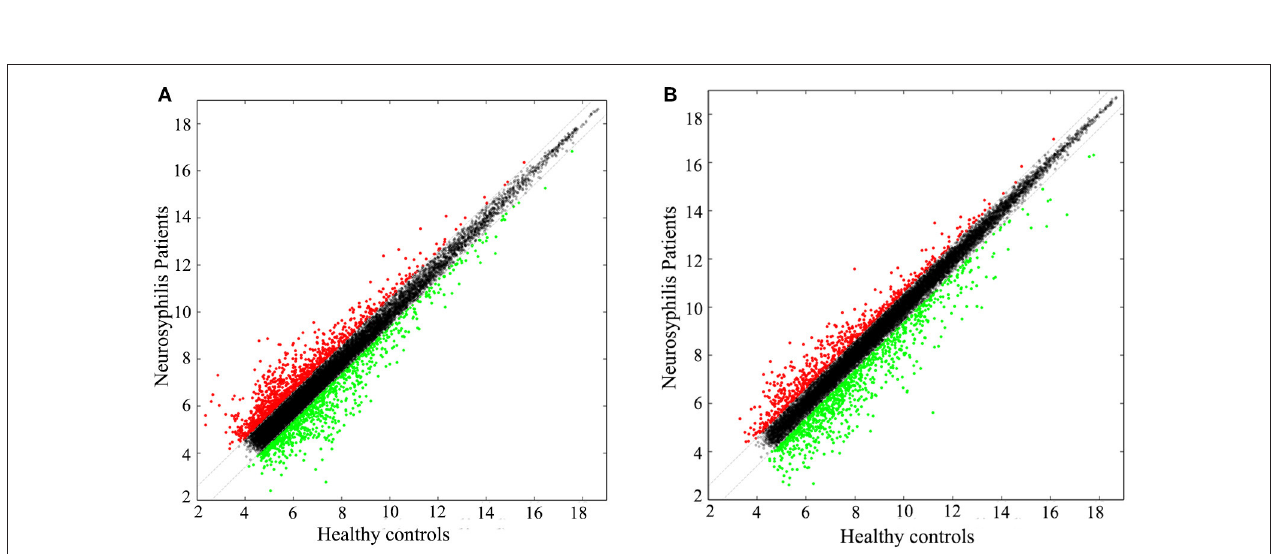
FIGURE 2 | The scatter plots show the lncRNA (A) and mRNA (B) expression profiles between the groups. A total of 2258 lncRNAs and 1728 mRNAs had a fold change > 1.5 and were considered over-expressed or under-expressed. The red dots indicate up-regulated expression, the green dots indicate down-regulated expression, and the black dots indicate RNAs with no significant differences between groups.